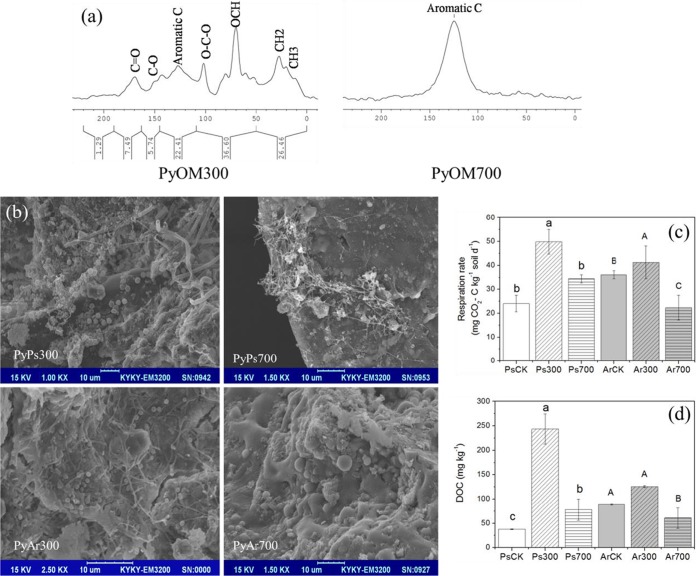
Relevant microbial biomass and activity parameters under PyOM300 and PyOM700 conditions. (a) NMR spectra. (b) SEM spectra. (c) Respiration rates. d, day. (d) DOC concentrations. Different lowercase and uppercase characters represent significant differences (P < 0.05) in the results seen with Ps and Ar treatments, respectively. SEM images were taken at the end of the incubation experiment to show the microbial colonization in PyOM particles that were extracted from soils.